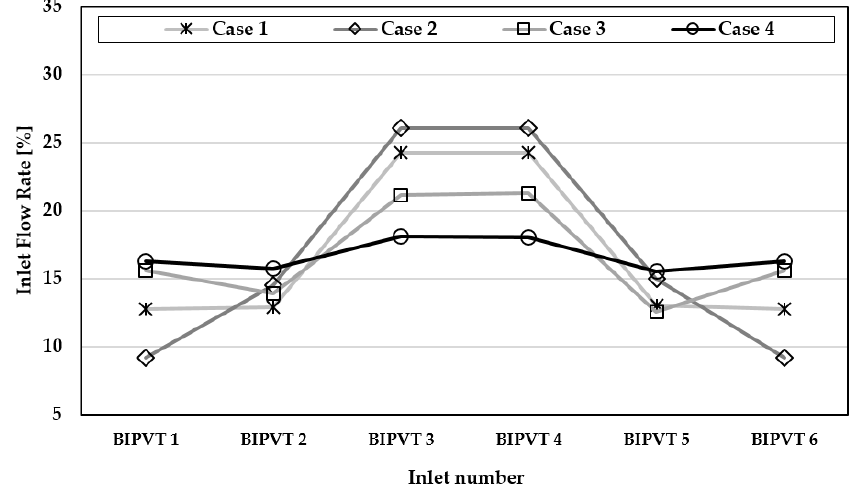
Figure 11. Inlet flow rate according to the inlet opening ratio.